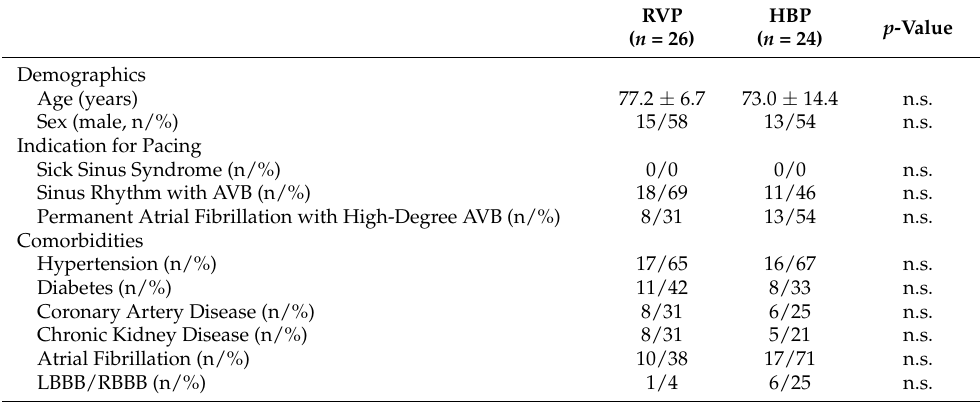
Table 1. Clinical characteristics of patients with right ventricular pacing (RVP) and His bundle pacing